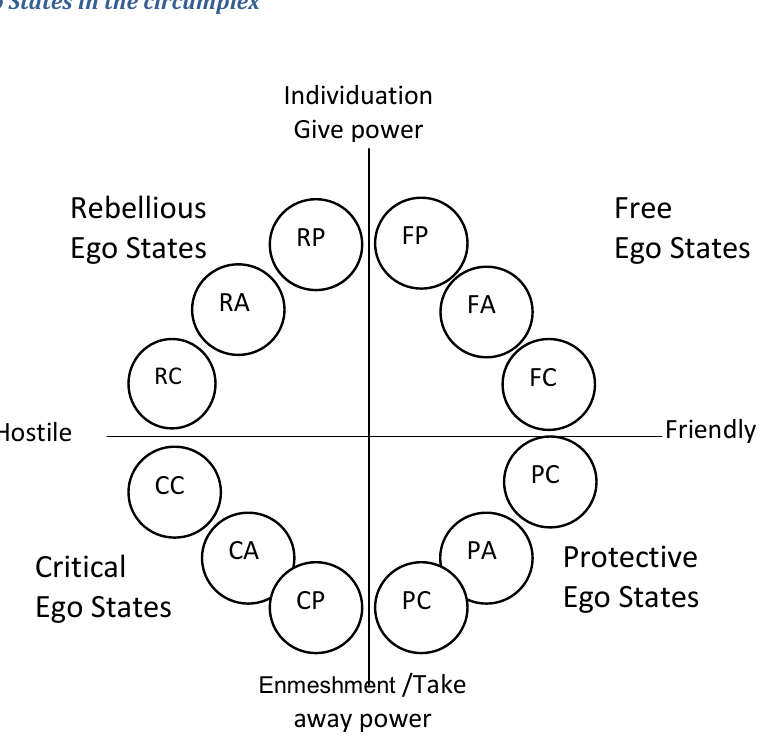
Figure 2: 12 Ego States in the